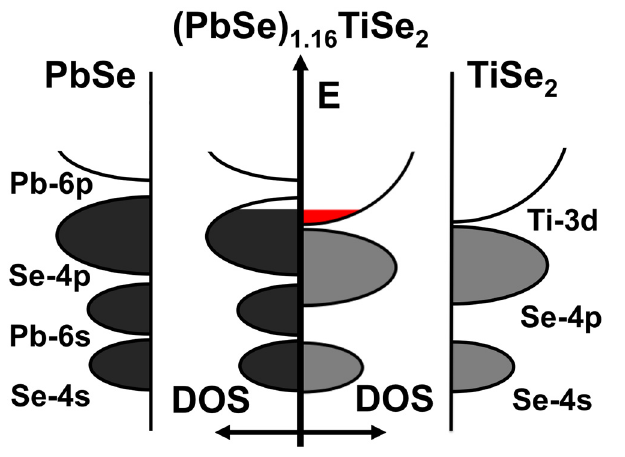
Figure 17. Schematic density of states diagram for (PbSe) 1.16 TiSe 2 and the parent compounds. All evidence presented to date supports the transfer of electrons from the MX layer to the TiX 2 layer, where conduction occurs. The transferred conduction electrons are shown in